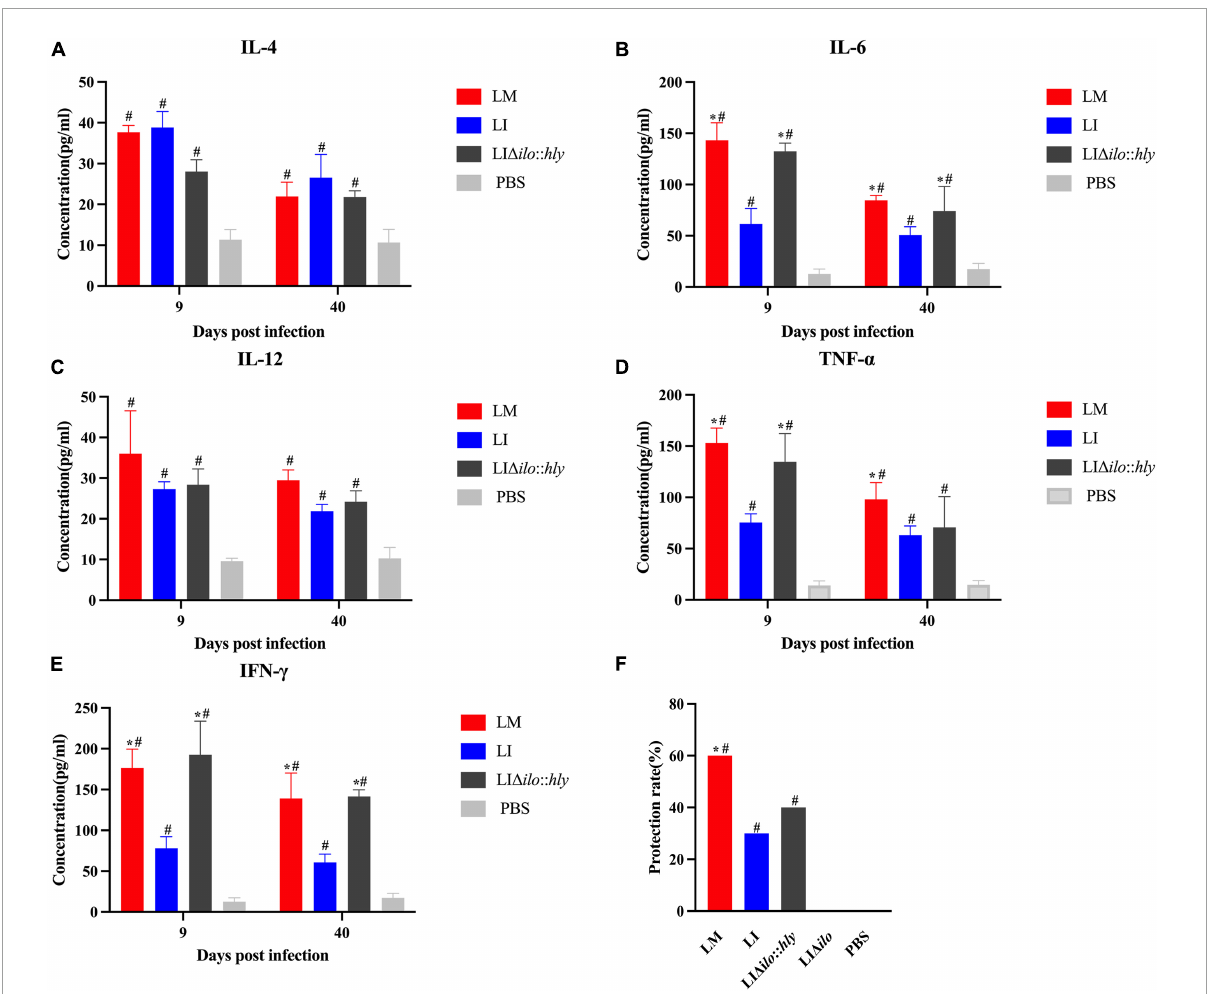
FIGURE6 Immunogenicity and immune protection of each strain. Cytokines IL-4 (A) , IL-6 (B) , IL-12 (C) , TNF- α (D) , and IFN- γ (E) at the 9th and 40th day after the secondary immunization of each strain, * P < 0.05, vs. Listeria ivanovii (LI); # P < 0.05, vs. PBS, the experiments were performed with biological triplicates. Each bar represents the mean ± SEM for a group of three mice from one independent experiment; Challenge protection rate after twice immunizations (F) , * P < 0.05, vs. LI; # P < 0.05, vs. PBS. Ten mice per group in this